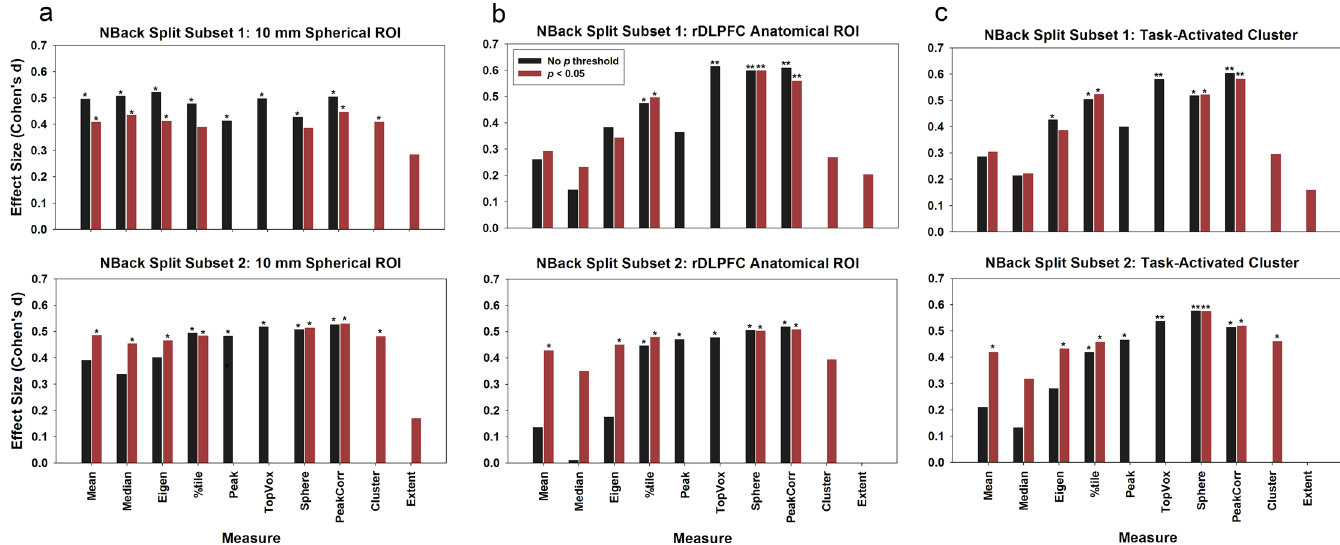
Fig 1. Using the NBack split dataset to evaluate the replicability of ROI summary measures. Three different strategies for ROI selection were used: (a) a 10-mm spherical ROI centered around the MNI coordinates xyz = [40 31 34]; (b) an anatomical ROI encompassing BA46 and lateral BA9; and (c) a task- activated cluster ROI. Asterisks denote significance level in group comparisons: * p < 0.05; ** p <